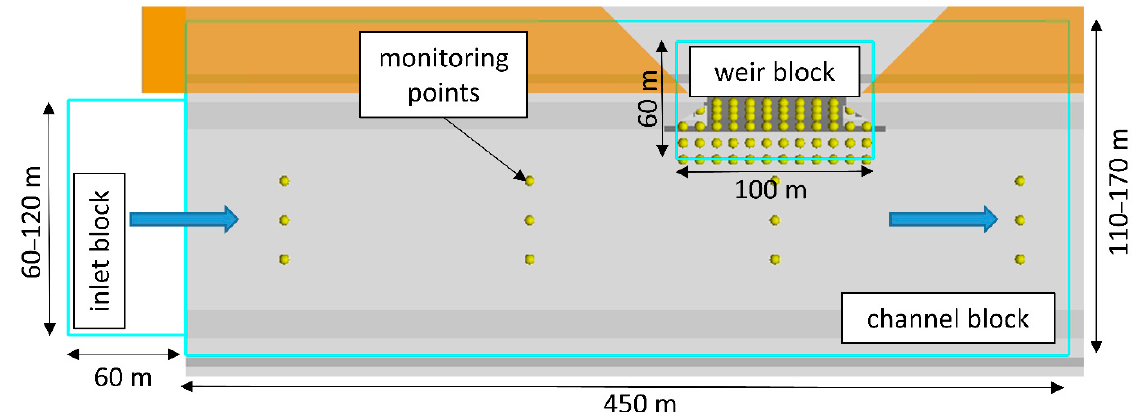
Figure 4. Arrangement and dimensions of the Cartesian mesh blocks (border lines in cyan blue), position of the defined monitoring points.